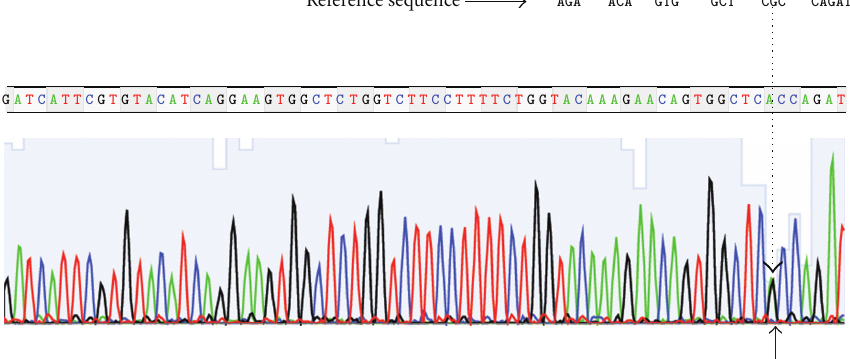
F 4: Photograph for exon 4 of ACVR1 gene for patient showing heterozygous missense mutation at the nucleotide 617 (c.617G leading to the substitution of the amino-acid arginine by histidine (p.Arg206His), note that patient will have the two types of ALK2 proteins (G and A bases appear overlapping at arrow